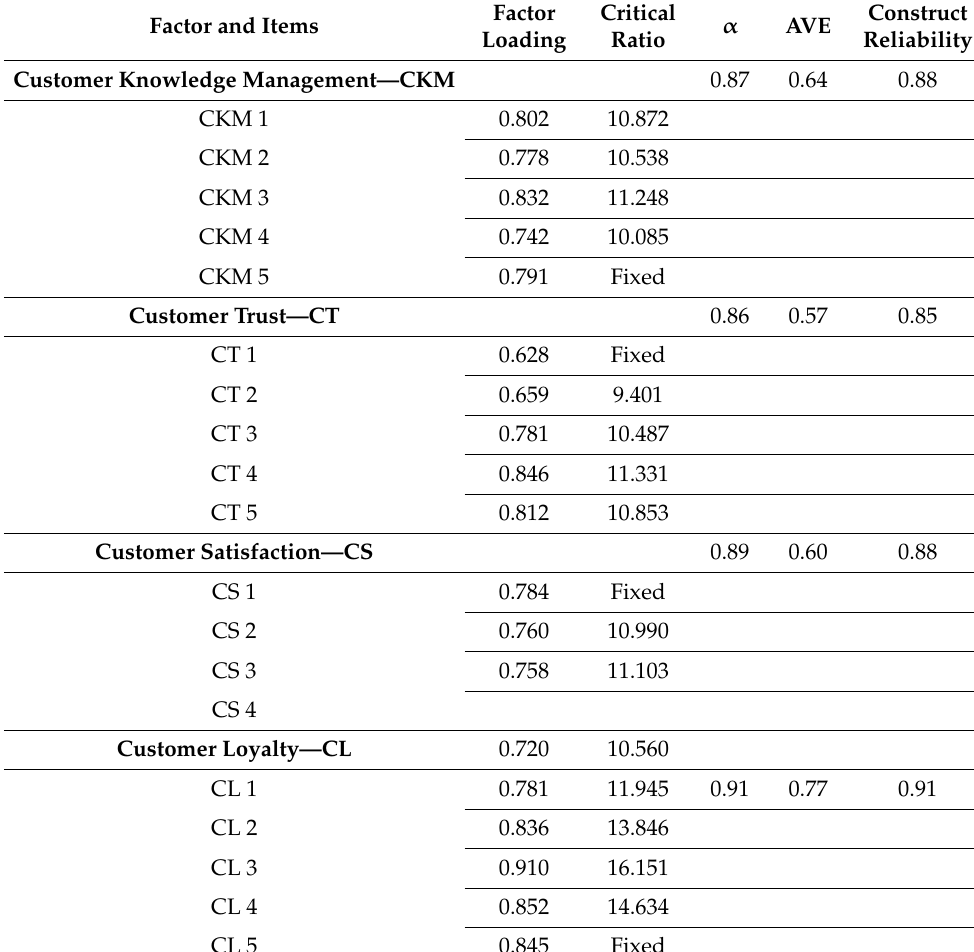
Table 3. Measurement model (CFA). Factor and Items AVE